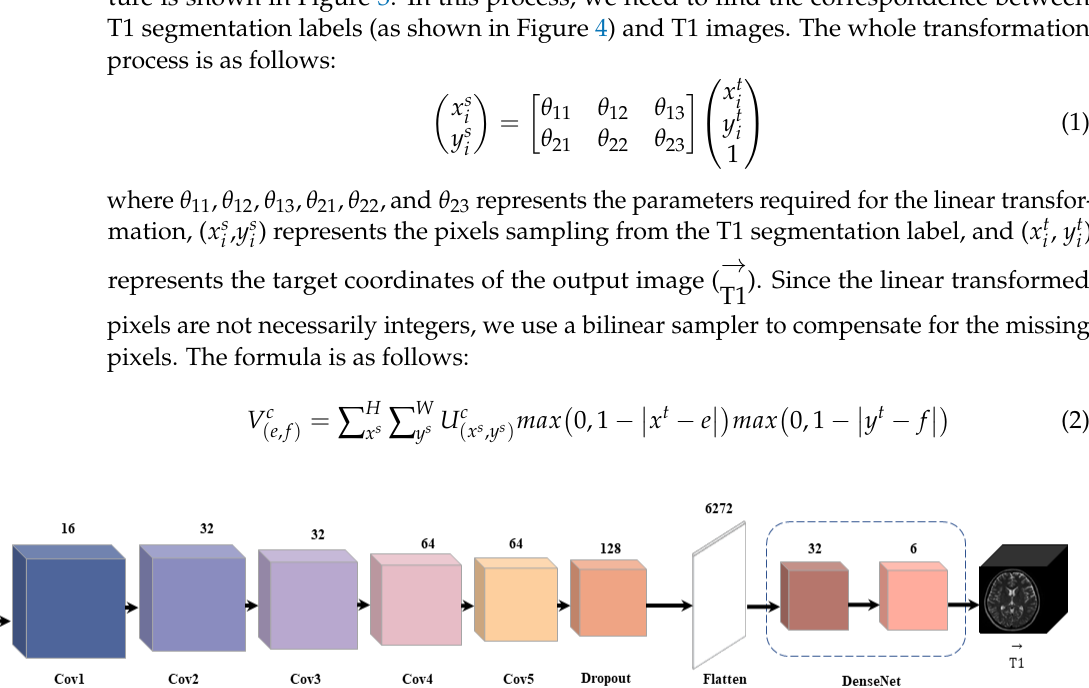
Figure 4. T1 segmentation label. A freehand spline drawing technique was used to segment all of the structures in the brain. The outline of each structure was delineated, starting with the innermost structures. By iteratively subtracting delineations to create holes, binary images were created for each structure. Segmentation was performed in a darkened room with optimal viewing conditions. The entire segmentation was inspected for correctness by an expert not involved in the segmenta- tion procedure and corrections were made if needed. A third expert approved the entirety of final segmentation. 3.2. Coarse Registration Network To reduce the challenge of large differences in multimodal images, we designed a coarse registration network. Specifically, we pre-align the T1 and T2 images using the same U-net as the pixel alignment network. In this way, images with fewer differences are transmitted to the pixel alignment network, which reduces the learning difficulty of the pixel alignment network.